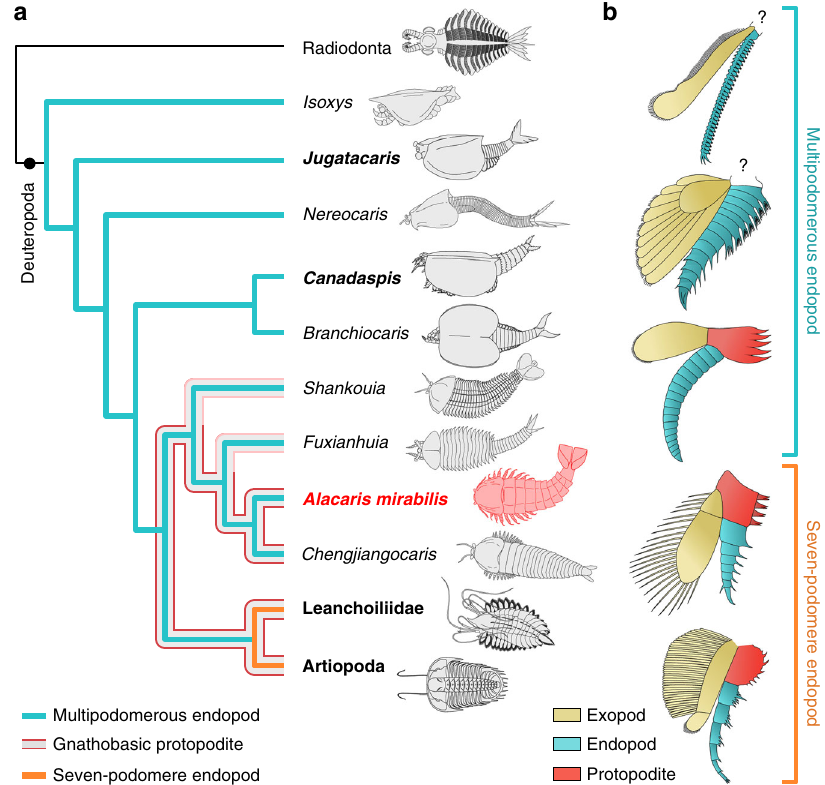
Fig. 5 Evolution of euarthropod PD limb axis differentiation. a Simpli fi ed cladogram showing phylogenetic position of Alacaris mirabilis , origin of the gnathobasic protopodite, and evolutionary reduction in the number of endopod podomeres within stem-group Euarthropoda (detailed results presented in Supplementary Fig. 5b); the presence of gnathobasic protopodites on the trunk limbs of Alacaris and Chengjiangocaris suggests their possible occurrence in other fuxianhuiid taxa for which proximal limb data are not currently available. b Post-deutocerebral appendage organization and homology among stem and crown-group euarthropods. Limb reconstructions correspond to taxa highlighted in bold in a , ordered from top to